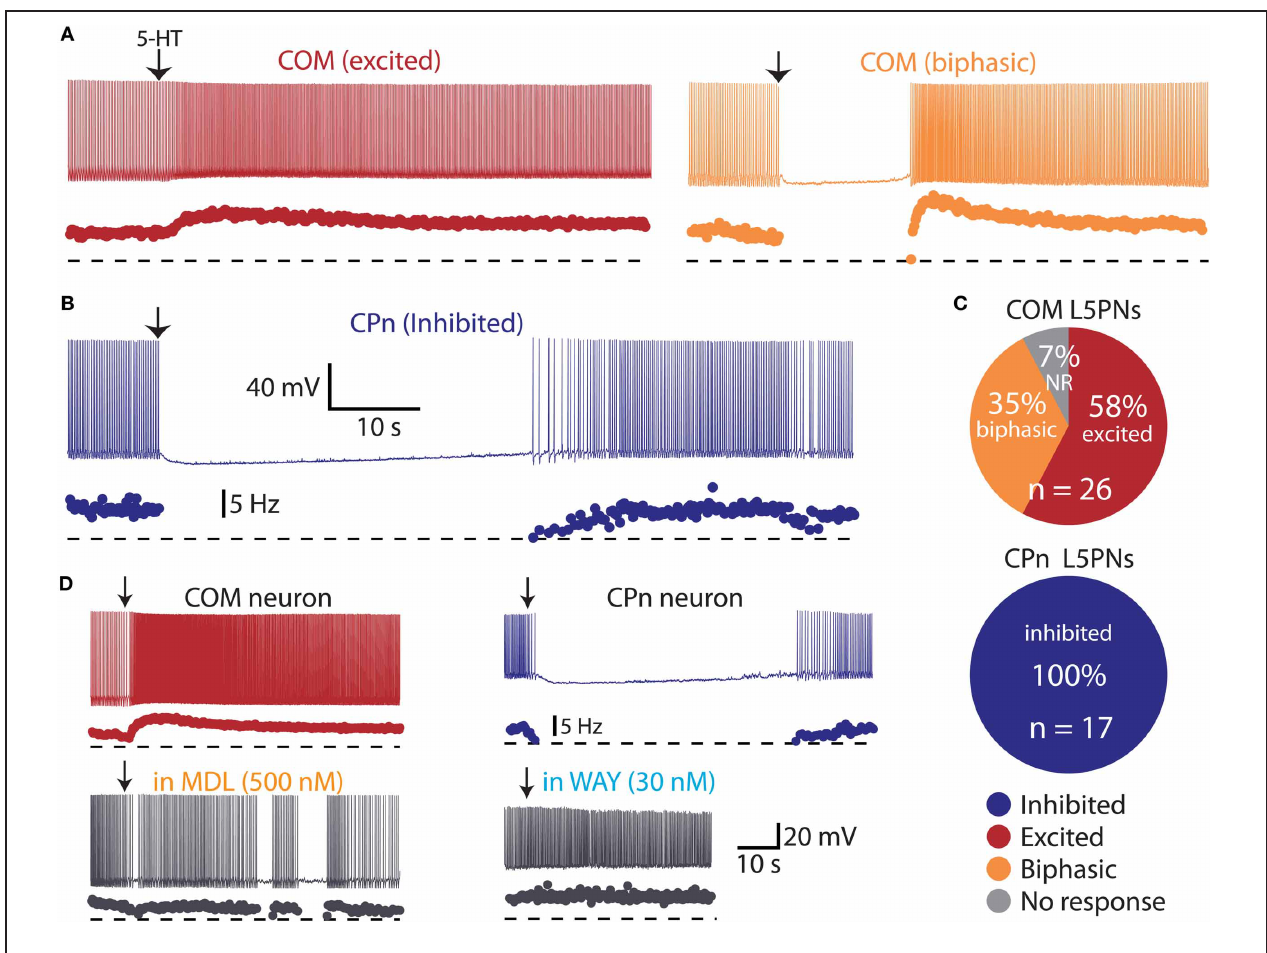
FIGURE 4 | Serotonin selectively excites commissural/callosal (COM) projection neurons. (A) Excitatory (left) and biphasic (right) responses to focal serotonin application in COM neurons. (B) Inhibitory response to serotonin in a corticopontine (CPn) neuron. (C) Proportion of COM and CPn neurons excited (red), inhibited (blue),